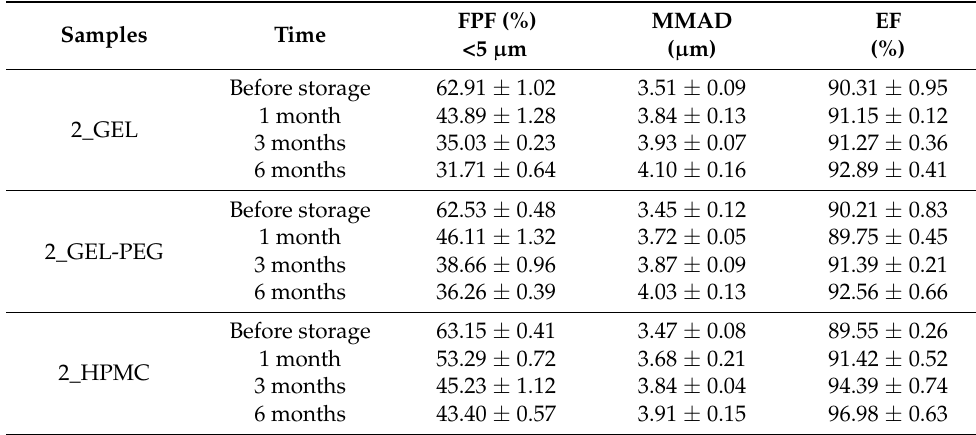
Table 8. Aerodynamic properties of the novel combined carrier-based samples.